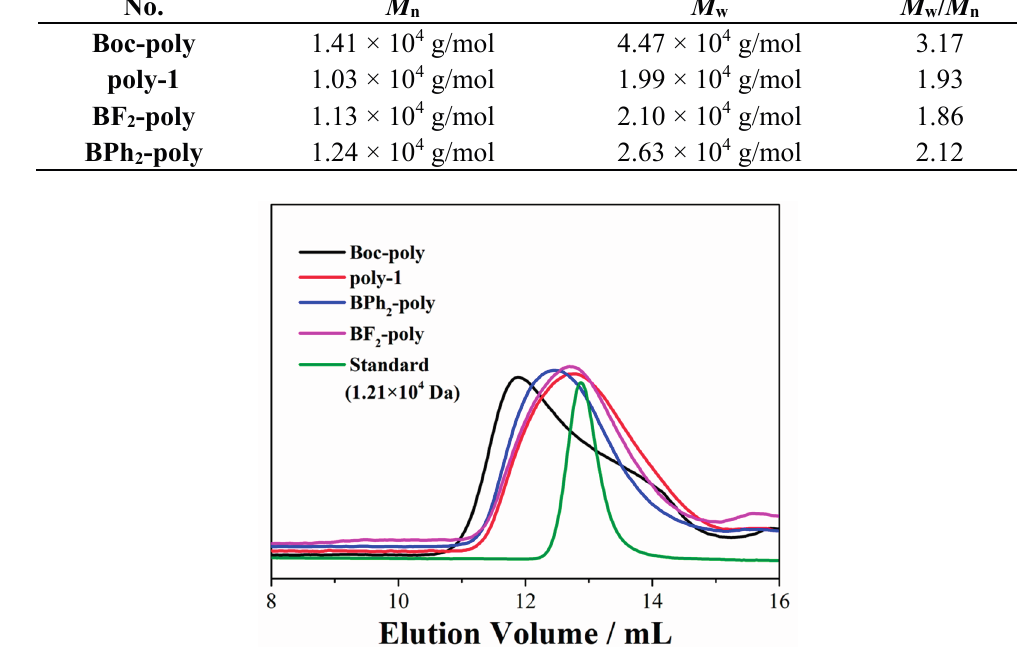
Figure 1. GPC elution